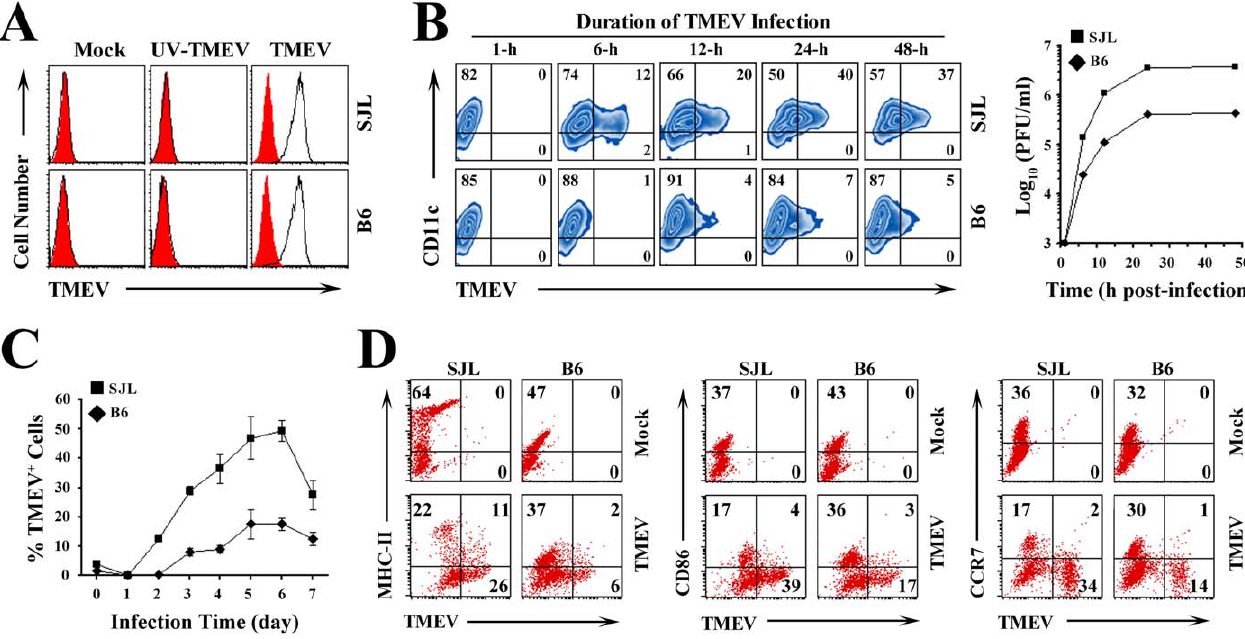
Figure 1. Elevated Viral Replication and Reduced Maturation of SJL DCs following TMEV Infection (A) For the virus binding assay, DCs obtained from a 5-d culture of primary BM cells were incubated with UV-inactivated TMEV or TMEV (MOI 10) for 1 h at 4 8 C, fixed with 1% PFA, and stained with anti-TMEV monoclonal antibody (open histogram) or isotype antibody (filled histogram) followed by FITC- conjugated secondary antibody. (B) To determine viral infection and replication levels, DCs were infected at MOI 10 for 1, 6, 12, 24, and 48 h. Expression of TMEV proteins in DCs was detected using anti-TMEV mAb and anti-CD11c antibody. Virus production was assessed by plaque assay. (C) The fraction of virus protein-positive cells was determined at different stages of culture of BMCs. (D) DCs were infected for 24 h and then analyzed for levels of maturation-associated markers (MHC-II, CD86, and CCR7, y -axis) and TMEV protein ( x -axis) by intracellular staining with gated CD11c þ cells.